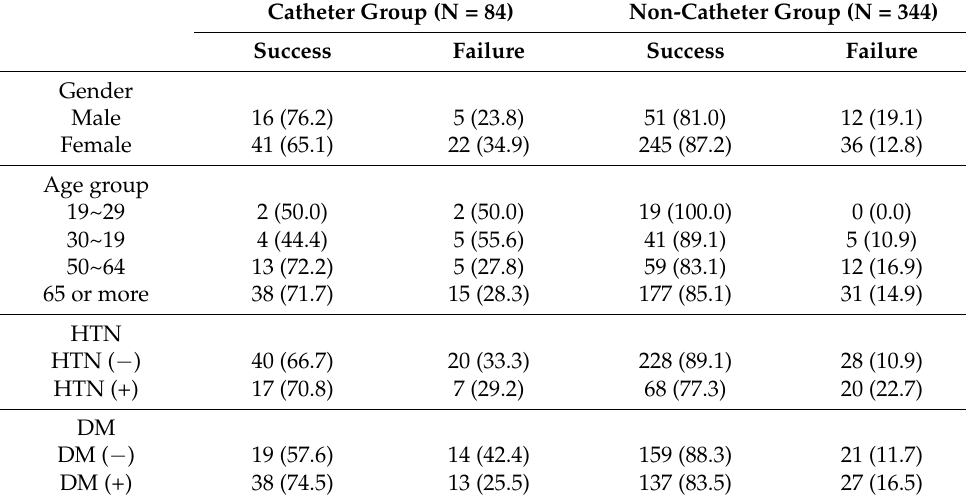
Table 5. Treatment success rate according to